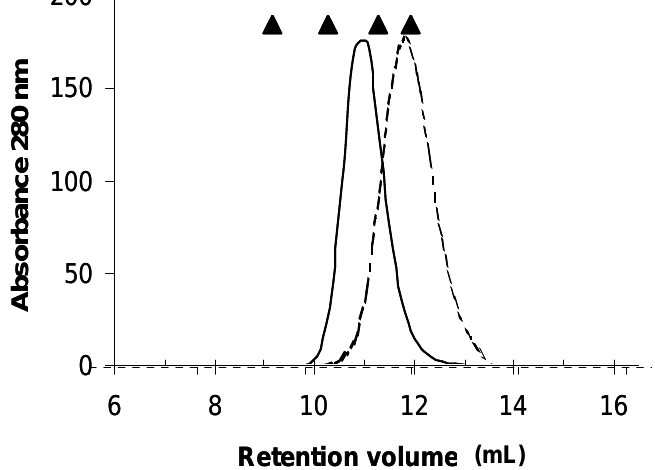
Figure 3. Analysis of oligomerization of the subunits of PAA by size exclusion chromatography on a superose 12 column (1.0 × 30 cm). Pure lectin was injected into the column and eluted at low ionic strength ( ) and 1 M NaCl ( ). Elution positions of the molecular weight standards (Thyroglobulin 660 kDa, aldolase 150 kDa, bovine serum albumin 67 kDa, and ovoalbumin 44 kDa) are indicated (